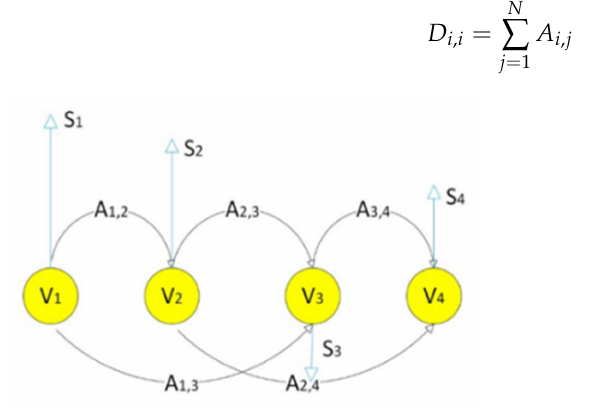
Figure 3. Structure of a graph showing vertices (V 1 to V 4 ), edges A i, j , and signals (S 1 to S 4